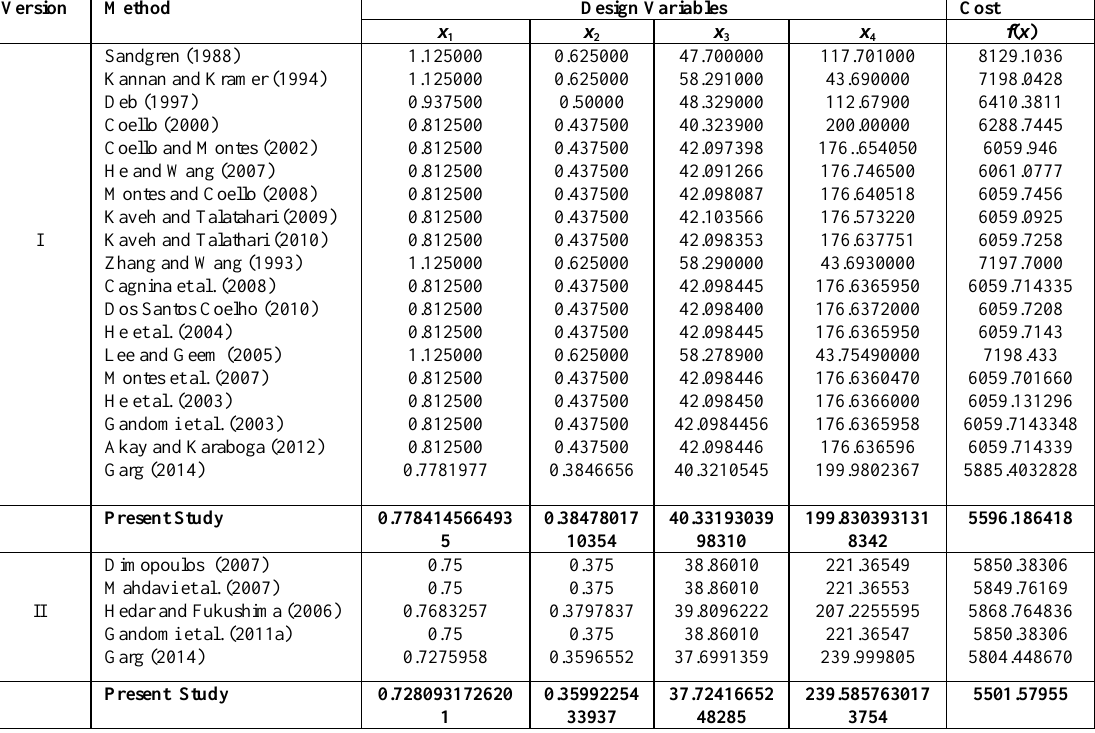
Table 1. Comparison of the best solution for pressure vessel design problem obtained by different methods